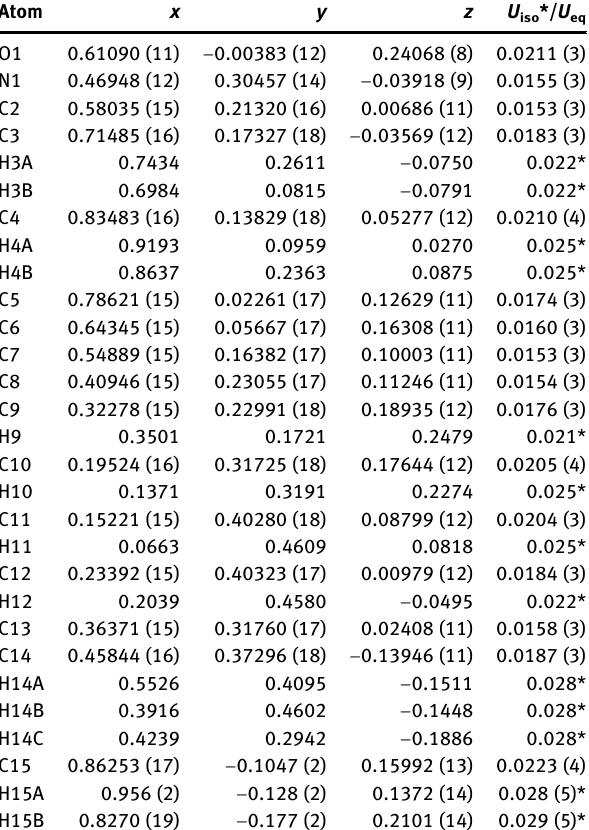
Table  : Fractional atomic coordinates and isotropic or equivalent isotropic displacement parameters (Å 